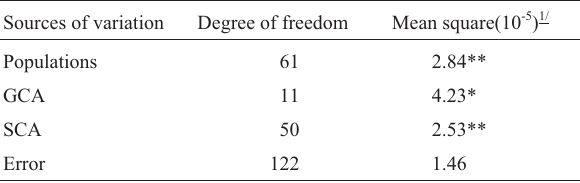
Table III - Variance analysis with decomposition of population effects in general and specific combining abilities, related to grain yield